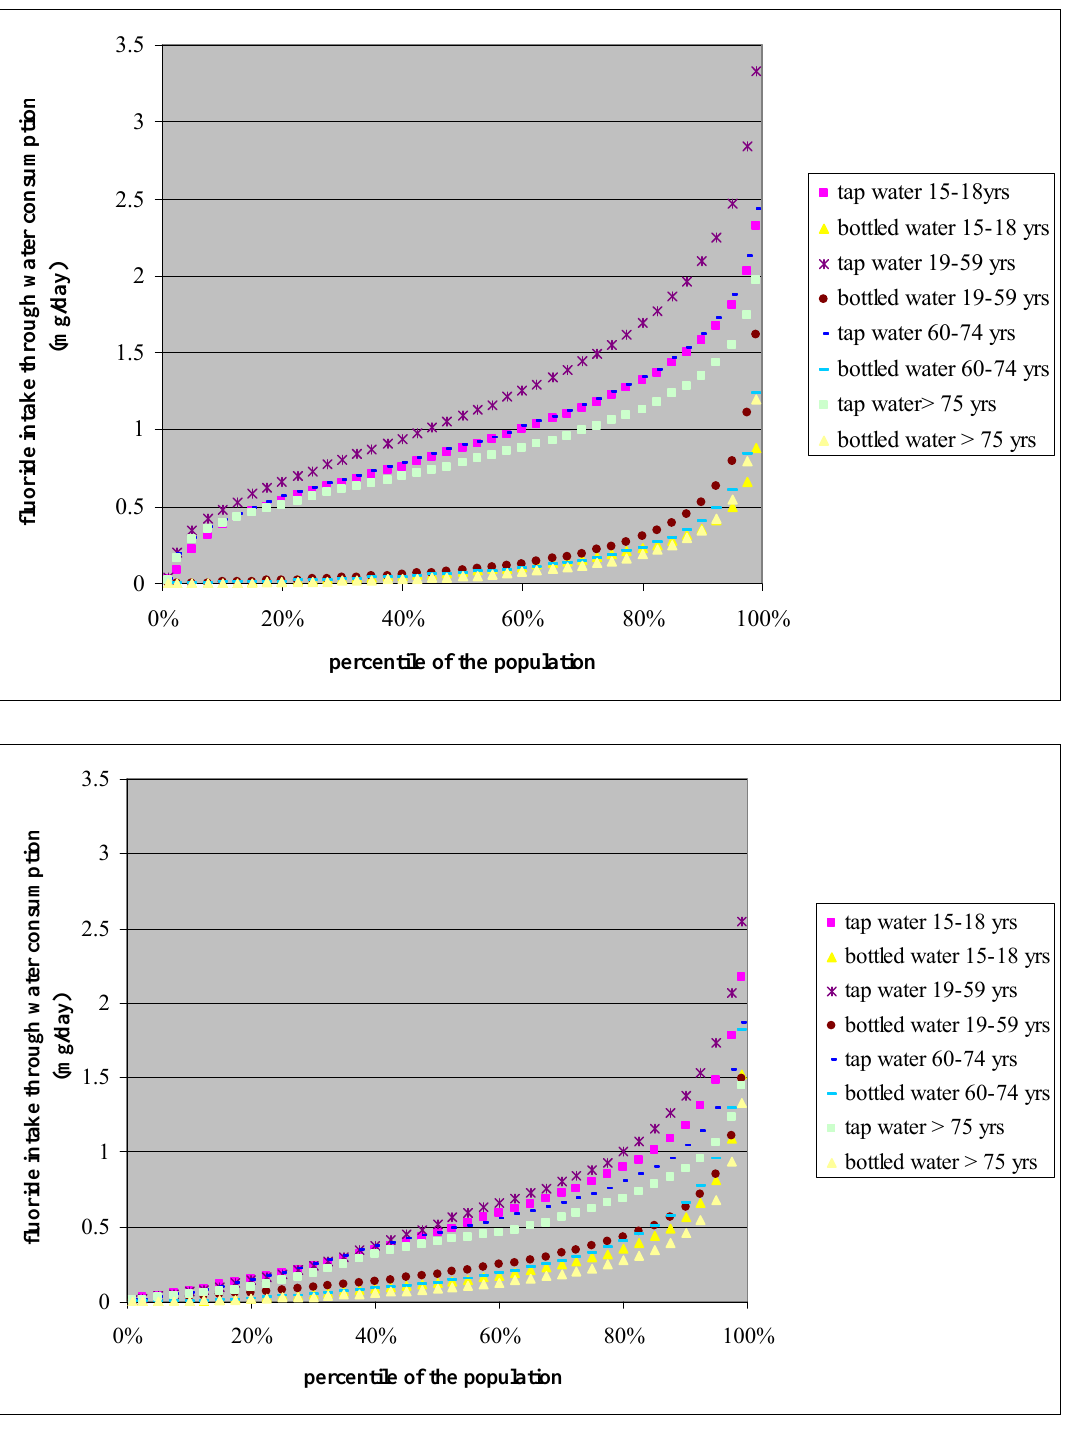
Figure 2. Fluoride intake (mg/day) through consumption of tap water and bottled water by age group, for Flanders (up) and the Walloon region (including Brussels)